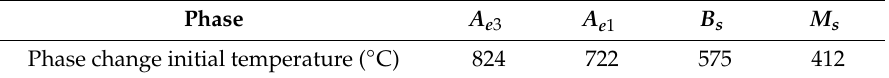
Table 2. Initial phase transformation temperature of USIBOR ® 1500 high-strength steel.